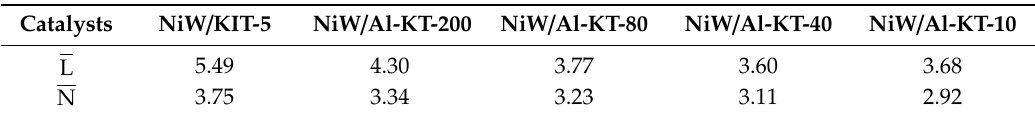
Table 3. HRTEM characterization of sulfide